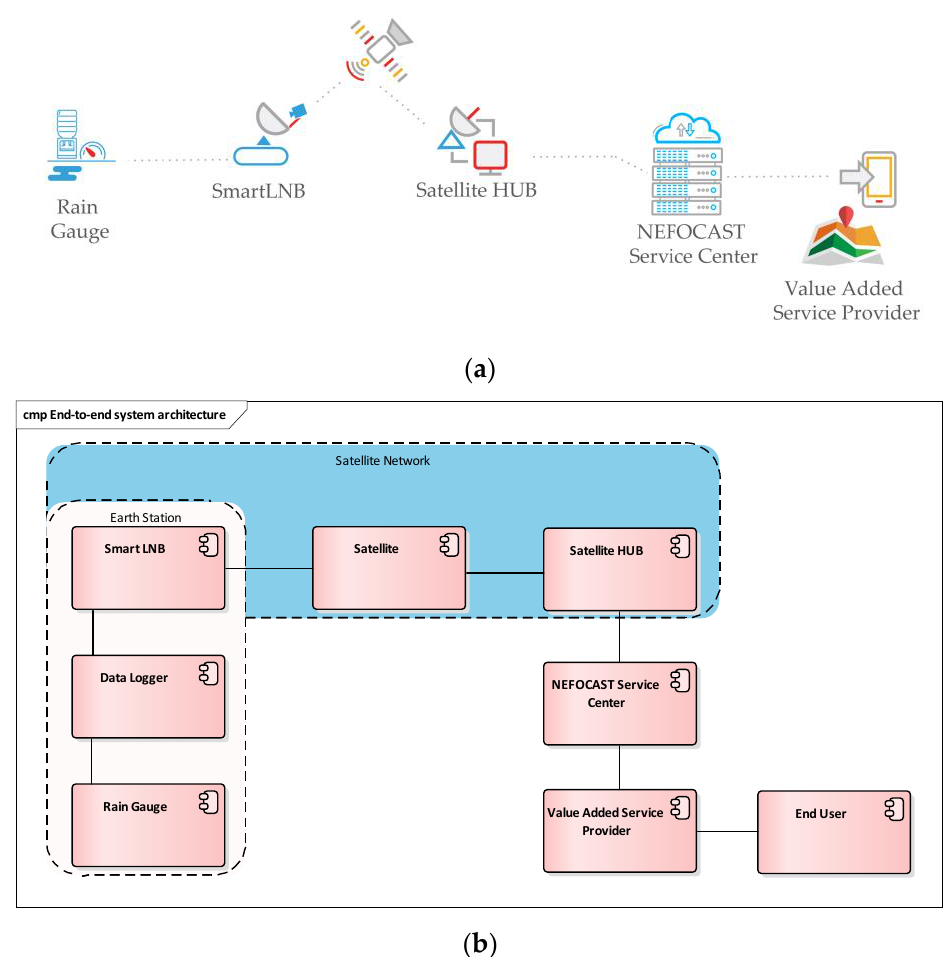
Figure 1. ( a ) NEFOCAST's experimentation network for real-time wide-area rain-rate measurement and ( b ) its high-level end-to-end architectural description.